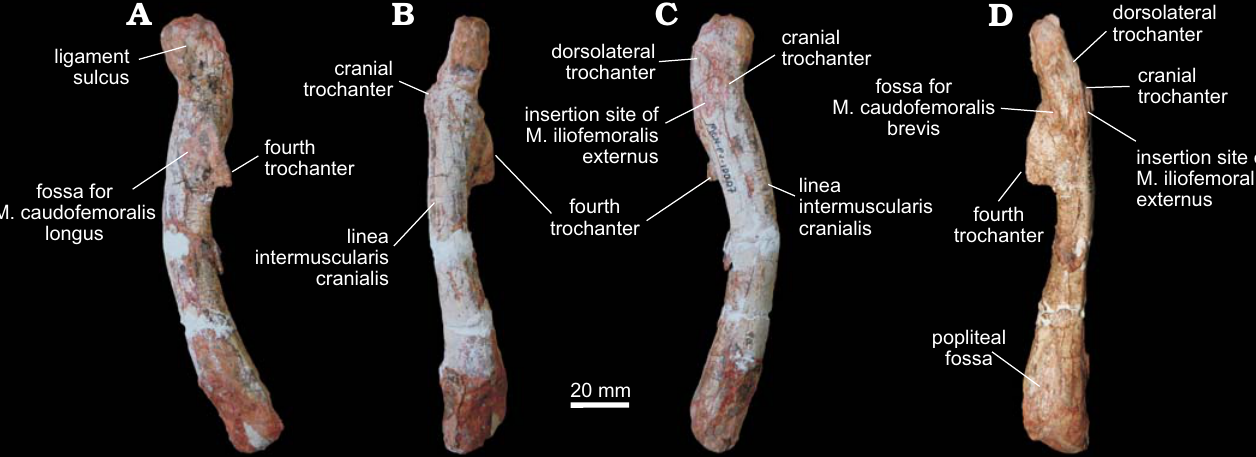
Fig. 6. Right femur of a sauropodomorph from Sacisaurus site, Late Triassic Caturrita Formation, Agudo, Rio Grande do Sul, Brazil; MCN PV10007 in medial ( A ), cranial ( B ), lateral ( C ), and caudal ( D ) views. Abbreviation: M.,